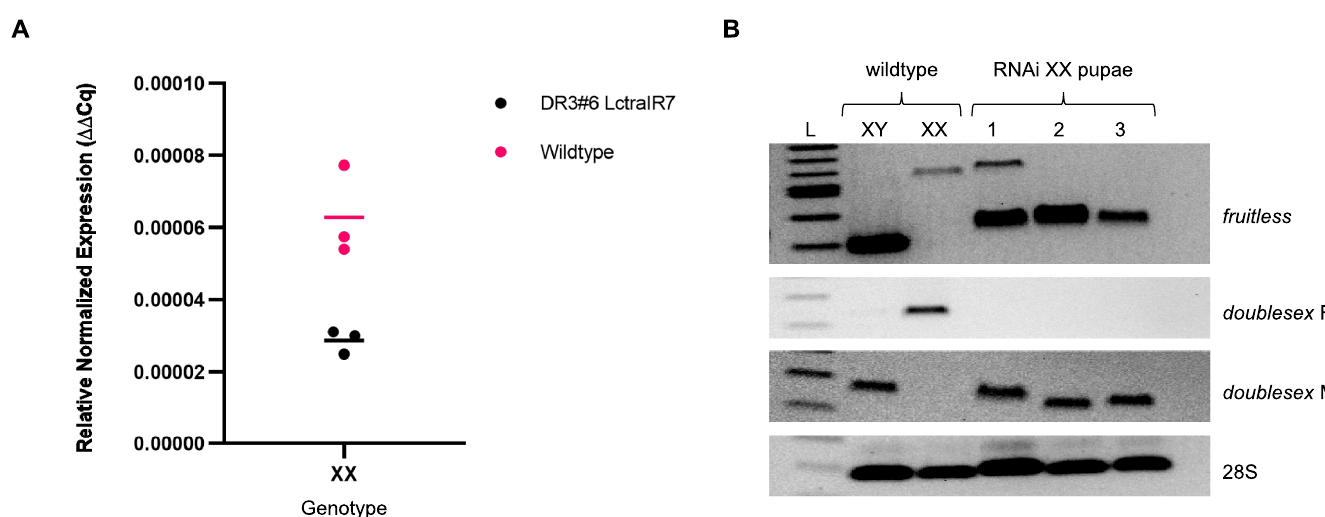
Fig 3. Knockdown of Lctra in XX pupae shifts the splicing of fru and dsx primarily to the male form. (A) qRT-PCR analysis of the RNA levels of Lctra in both wildtype and DR3#6; LctraIR7 XX mid-staged pupae. Expression of Lctra in DR3#6; LctraIR7 XX flies is significantly lower than in wildtype (P = 0.025, Student’s t- test). Three biological replicates and mean expression are shown for each sample type. (B) RT-PCR analysis of L . cuprina fruitless and doublesex splicing patterns in RNAi knockdown XX mid-staged pupae compared to wildtype XX and XY controls. 28S rRNA primer set used as positive control.